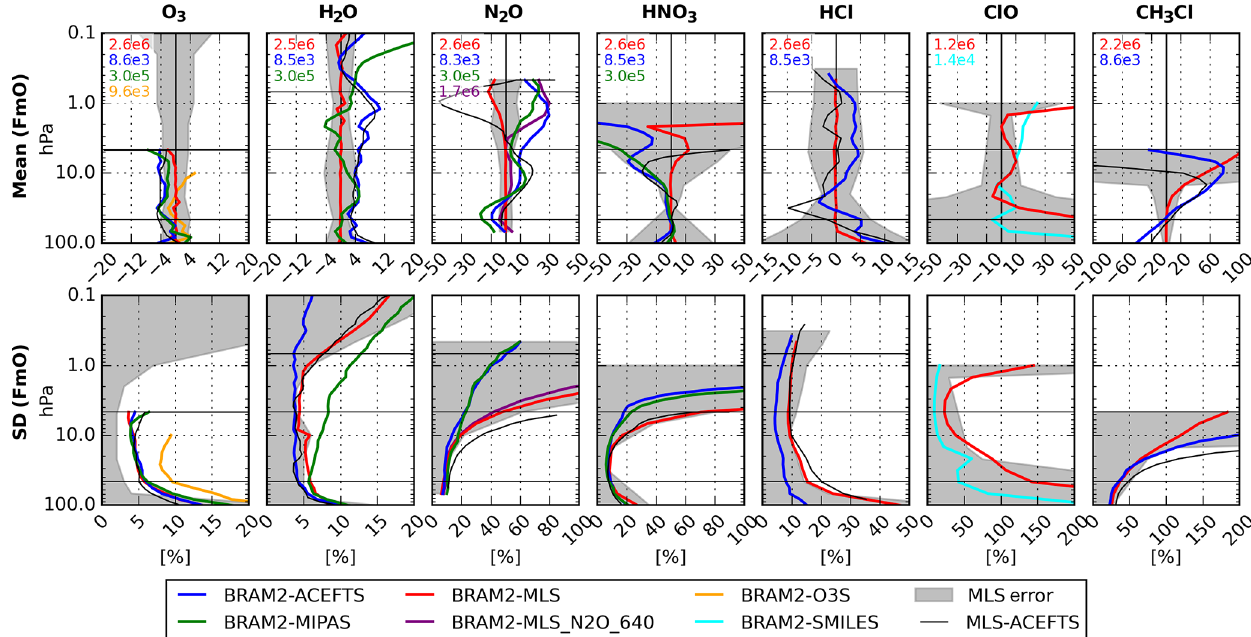
Figure 5. Mean (top row) and standard deviation (bottom row) of the differences between BRAM2 and observations from MLS (red lines), ACE-FTS (blue lines), MIPAS (green lines), MLS_N2O_640 (purple lines), NDACC ozonesondes (orange lines) and SMILES (cyan lines). The statistics are in percent, normalized by the mean of BRAM2, and are taken between 30 and 60 ◦ N and between 0.1 and 100hPa. The period is 2005–2017 except for MIPAS (2005–2012), MLS_N2O_640 (2005–2013) and SMILES (October 2009–April 2010). The statistics are calculated for, from left to right, O 3 , H 2 O, N 2 O, HNO 3 , HCl, daytime ClO and CH 3 Cl. The approximate numbers of observed profiles used in the FmO statistics are given in the upper left corner of the top row plots using the instrument colour code. The grey shaded area in the mean and standard deviation plots corresponds, respectively, to the MLS accuracy and precision, as provided in the MLS data quality document (see L2015). The thin black profiles represent the mean (top row) and standard deviations (bottom row) between MLS and ACE- FTS found in validation publications (see text for details). The horizontal black lines denote levels where time series are shown in Fig.